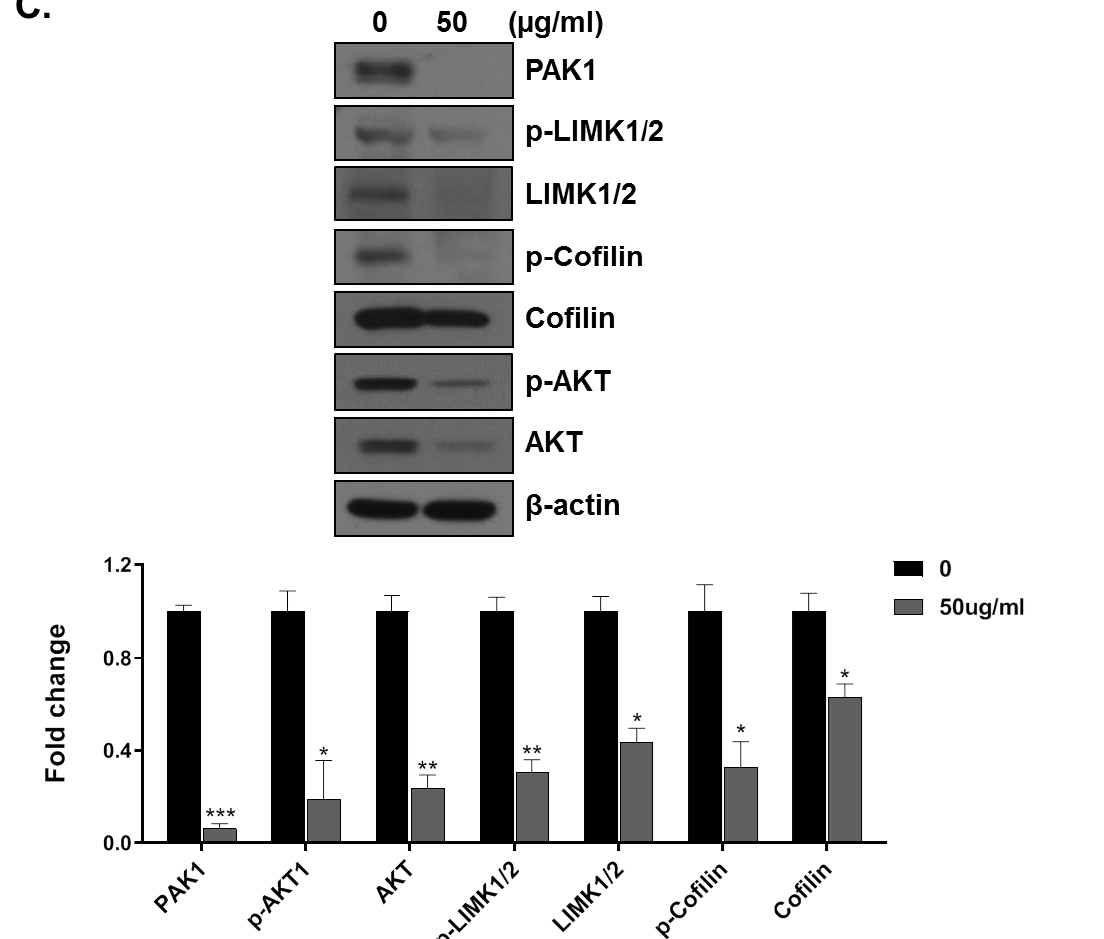
Figure 2. Inhibitory effect of HMT on cell migration and invasion in PC-3 cells. Cells were treated with HMT (50 μg/mL) for 24 h. ( A ) The cells invading into the Matrigel-coated membrane were photographed (X100), and the number of invasive cells was calculated as a percentage of invasion. ( B ) The cells migrating into the scratched area were photographed (X100), and the number of migratory cells was calculated as a percentage of migration. ( C ) HMT-treated PC-3 cell lysates were prepared and subjected to Western blotting for cell motility-related proteins in the PAK-1 signaling pathway (PAK-1, LIMK1/2, p-LIMK1/2, cofilin, p-cofilin, AKT, p-AKT, and β-actin). The bar graph indicates the ratio of the protein of interest to β-actin by densitometric analysis presented as fold changes of the control. Data represent mean ± SD. * p < 0.05, ** p < 0.01, and *** p < 0.001 compared with control.